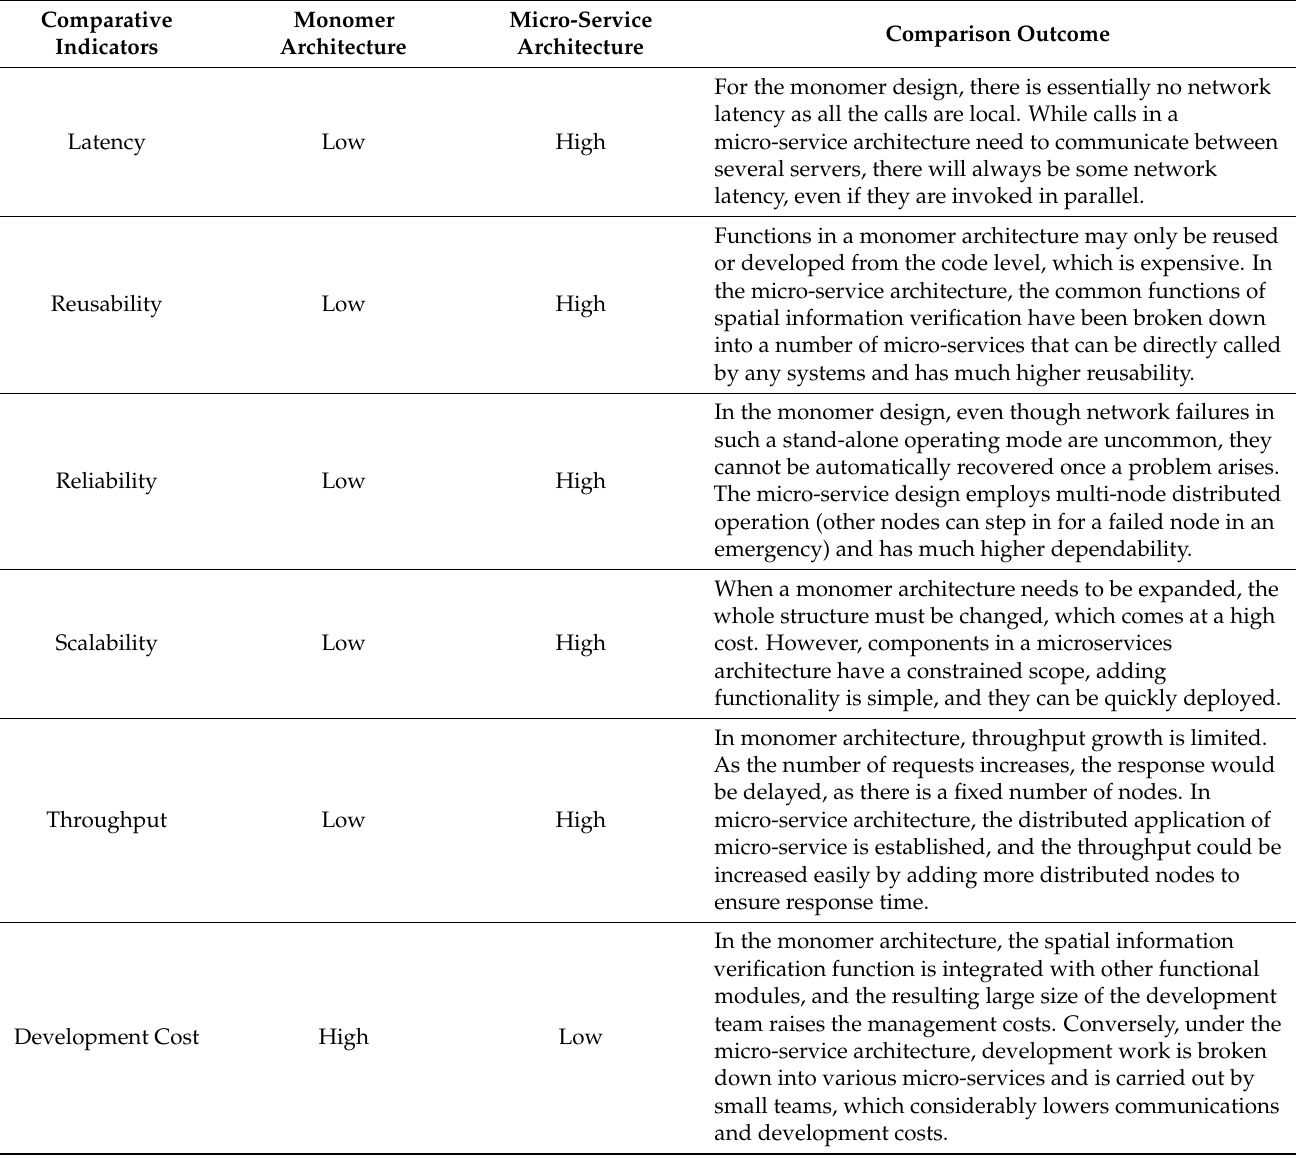
Table 1. Comparison of related indicators between monomer architecture and micro-service architec- ture in the construction of spatial information verification